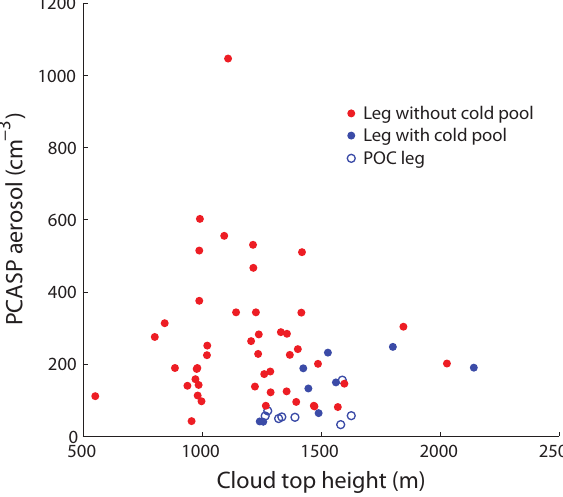
Fig. 7. Leg-mean cloud base precipitation rates, estimated from WCR radar reflectivity and Z – R relationship from Comstock et al. (2004), are plotted against the leg-mean cloud thicknesses for legs with (blue) and without (red) cold pools. Open circle indicate legs located in pockets of open cells, all of which had cold pools.